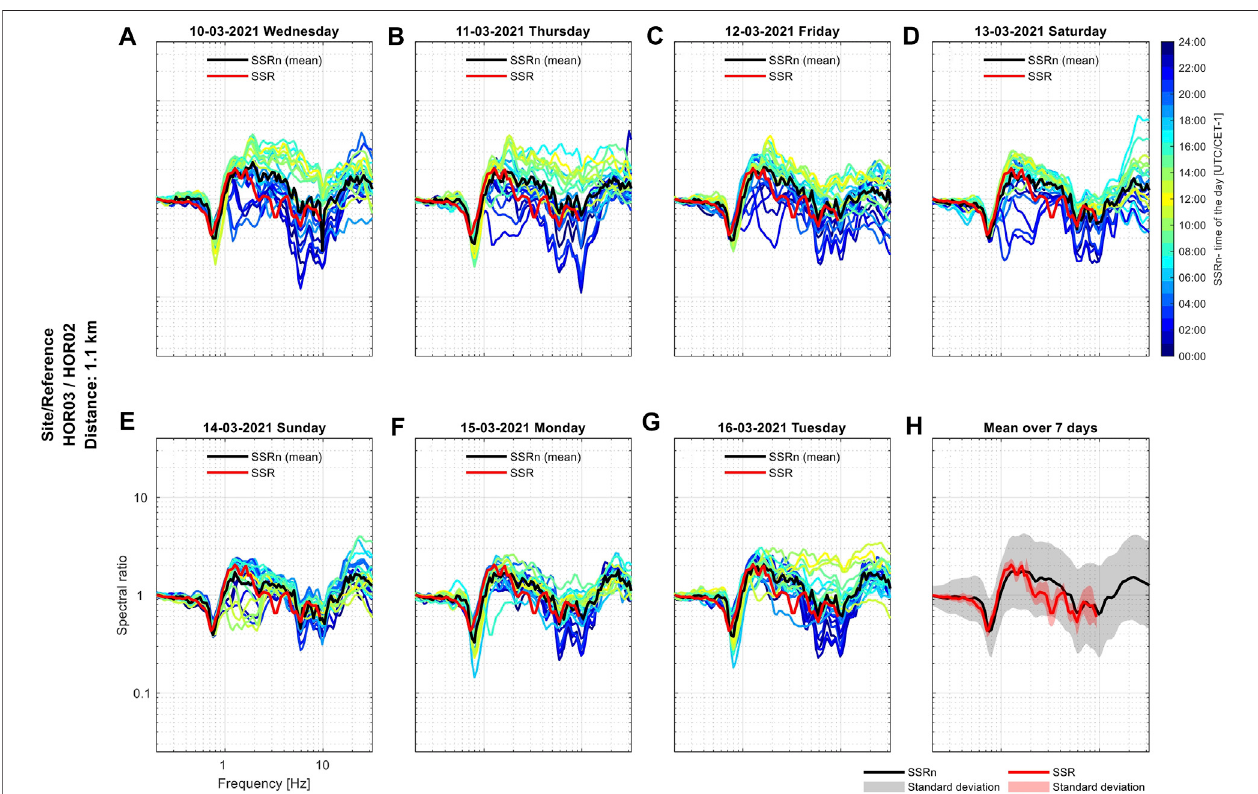
FIGURE 11 | Example of the in fl uence of ambient noise daily variations on SSRn. Each of the plots (A – G) corresponds to one day and each line to one hour of recording. The colors indicate the time of the day when noise was recorded. The black line is a mean over 24 h, and the red line is SSR. Plot (H) shows the mean SSRn over 7 days with standard deviation compared to the